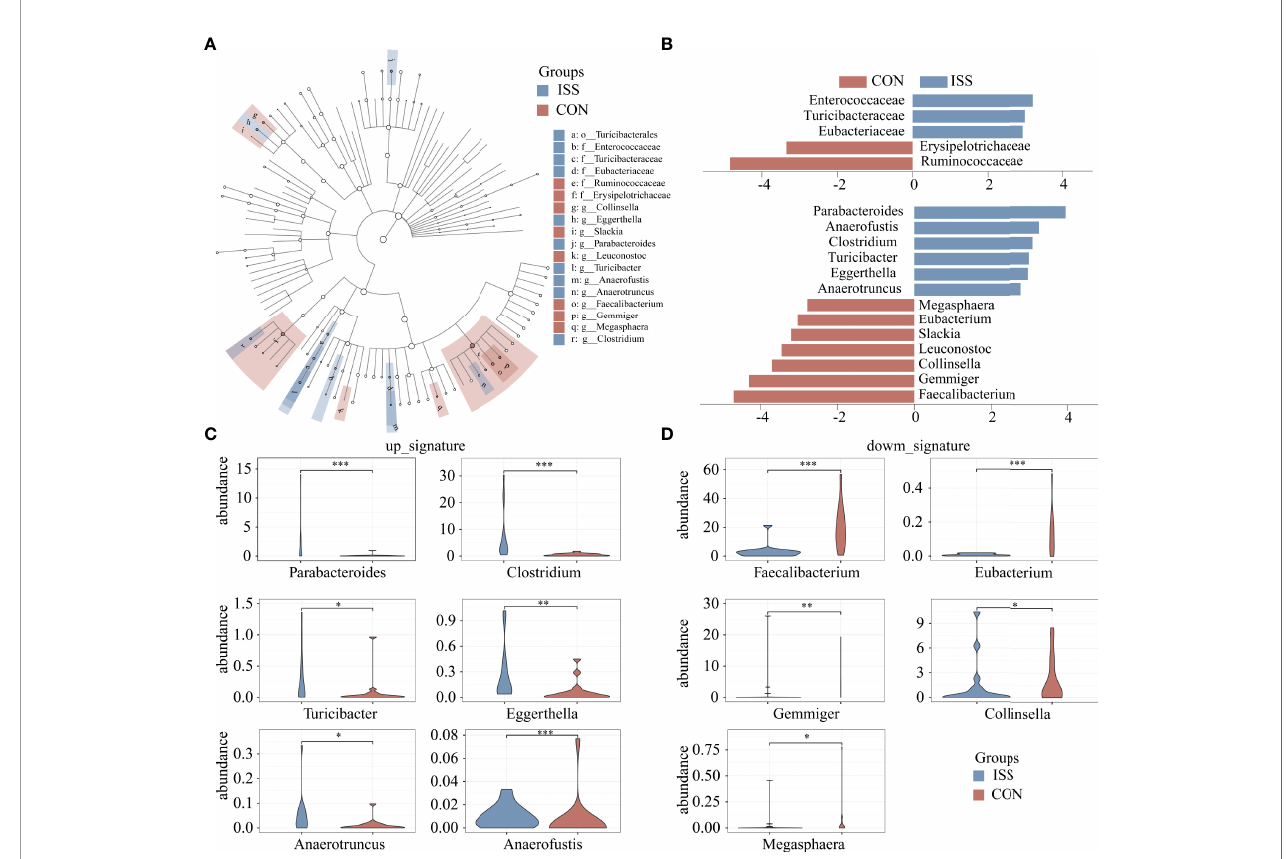
FIGURE 3 | Cladogram based on LEfSe results of the CON and ISS groups. The blue points represent the increased taxa in ISS group, while the red points represent the increased taxa in CON group (A) . (B) Linear discriminant analysis effect size (LEfSe) algorithm of intestinal microbiota at the family and genus levels (LDA > 2.5). (C, D) Violin plots depict the relative abundances of the top 11 discriminatory species in the ISS and control groups. ISS, Idiopathic short stature; CON, healthy subjects serving as controls. *P < 0.05; **P < 0.01; ***P <